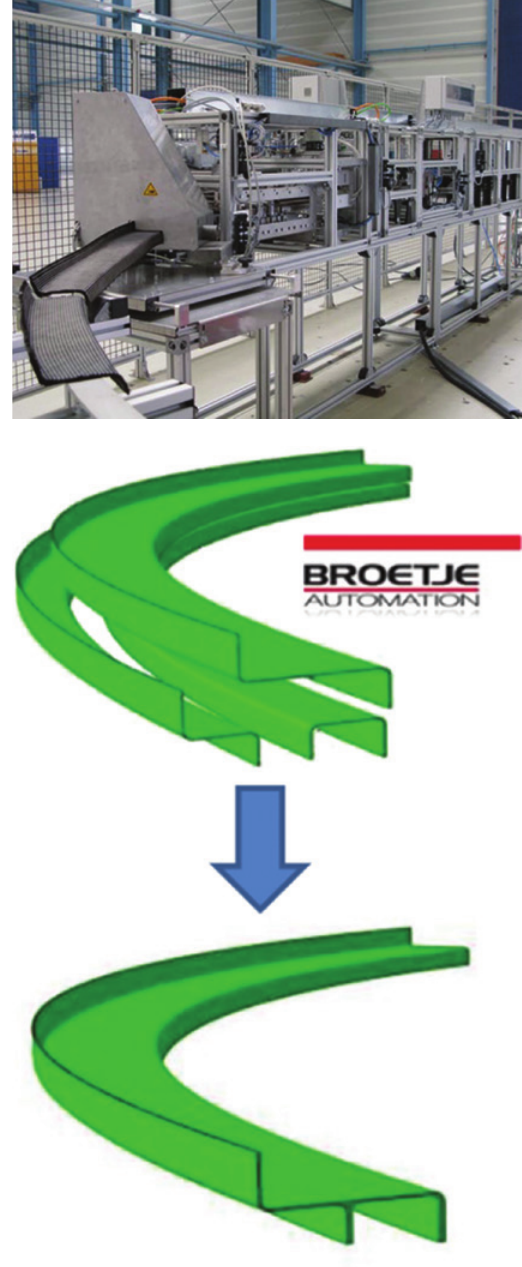
Figure 7: Processing line for an axially curved, Z-shaped preform (top) and scheme for setting up a preform with comparatively complex cross-sectional geometry from three sub-preforms (bottom). Source: Brötje Automation